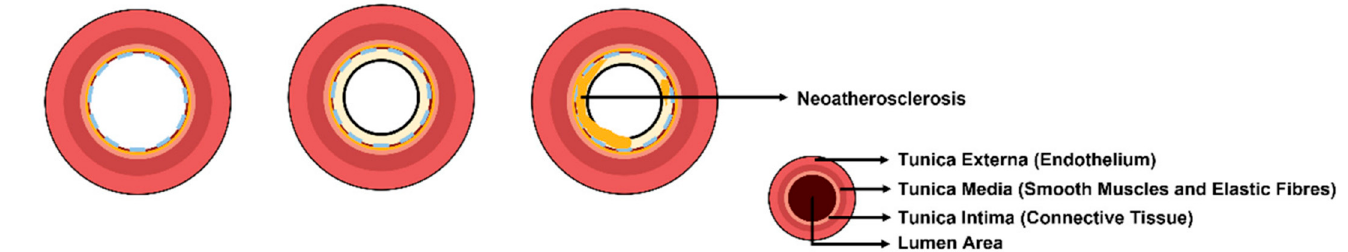
Figure 1. Schematic of the cross-section of a blood vessel and the formation of an atherosclerotic plaque (adapted from [6]).